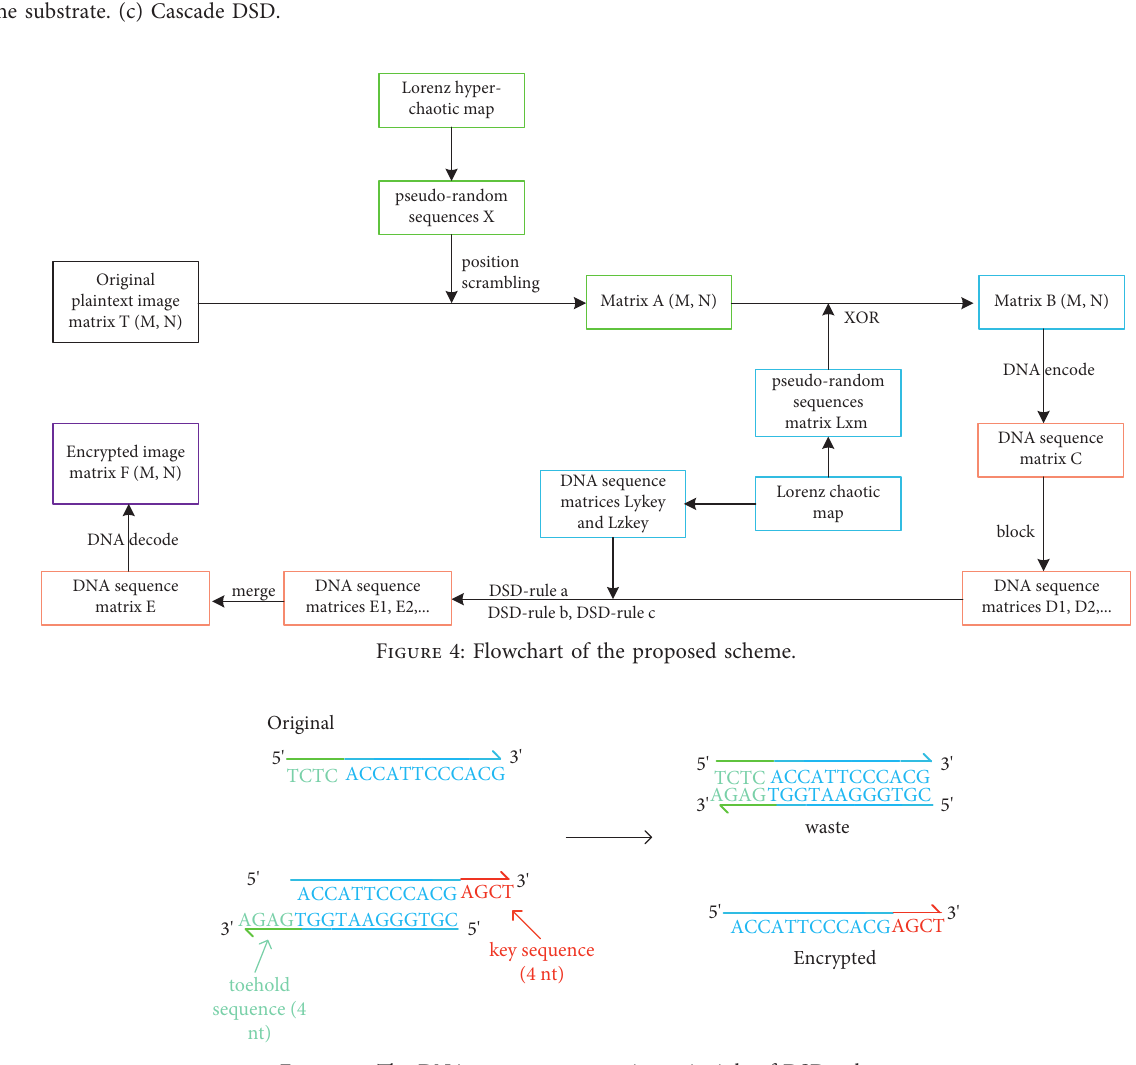
Figure 5: The DNA sequence encryption principle of DSD-rule